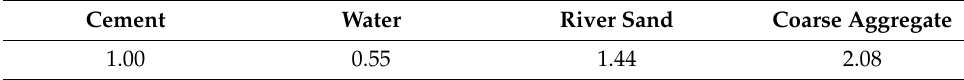
Table 2. Mixture ratio of model pile concrete (mass). Cement Water